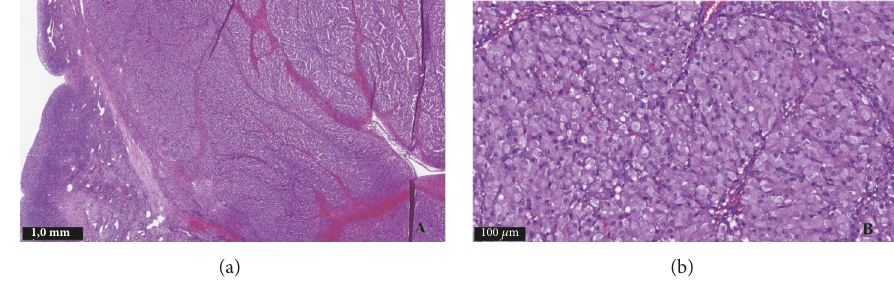
Figure 1: Hematoxylin and eosin staining of the surgical specimen.